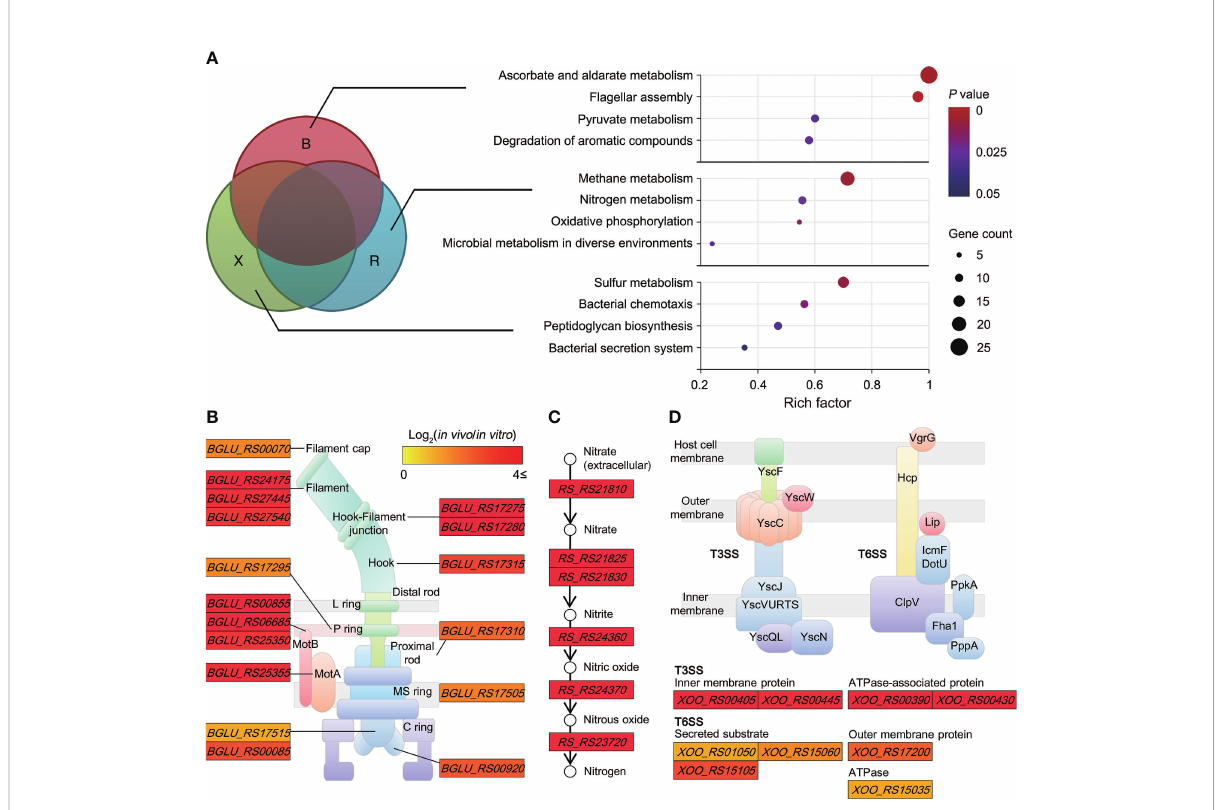
FIGURE 3 Biological pathways uniquely induced in non-orthologous groups (A) Scatterplot showing biological pathways signi fi cantly enriched in unique genomes (B group, ( B ) glumae ; R group, R. solanacearum ; and X group, Xoo ). The rich factor on the x -axis refers to the ratio of the number of DEGs to the background number of annotated genes in the pathway. The size of the dot indicates the number of genes, while the color indicates the P -value range. The Cytoscape tool was used to construct networks depicting highly concentrated reactions, as follows: (B) fl agellar assembly in ( B ) glumae BGR1; (C) nitrogen metabolism in R. solanacearum GMI1000; and (D) bacterial type III and VI secretion systems in Xoo KACC10331. Two node types are illustrated: rectangular, functional protein and circular, and biological chemical. Color differences are indicative of corresponding expression changes in log 2 ( in planta / in vitro ) values, with darker red representing genes upregulated in planta